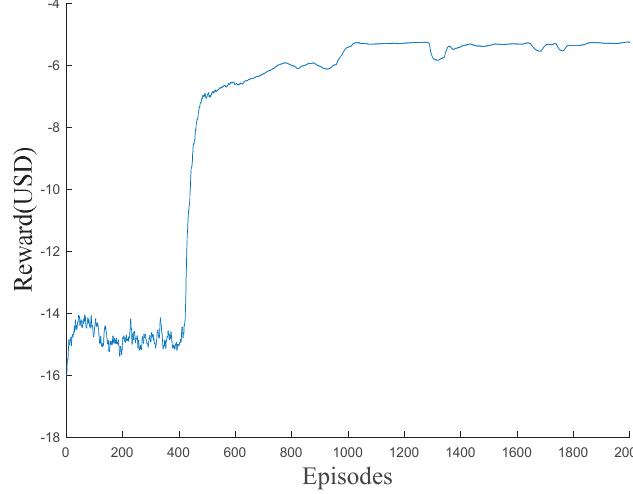
Figure 10. Convergence curve of the DDPG algorithm. From Figure 11a, we can see that, in the time period from 8:00 to 17:00, the PV